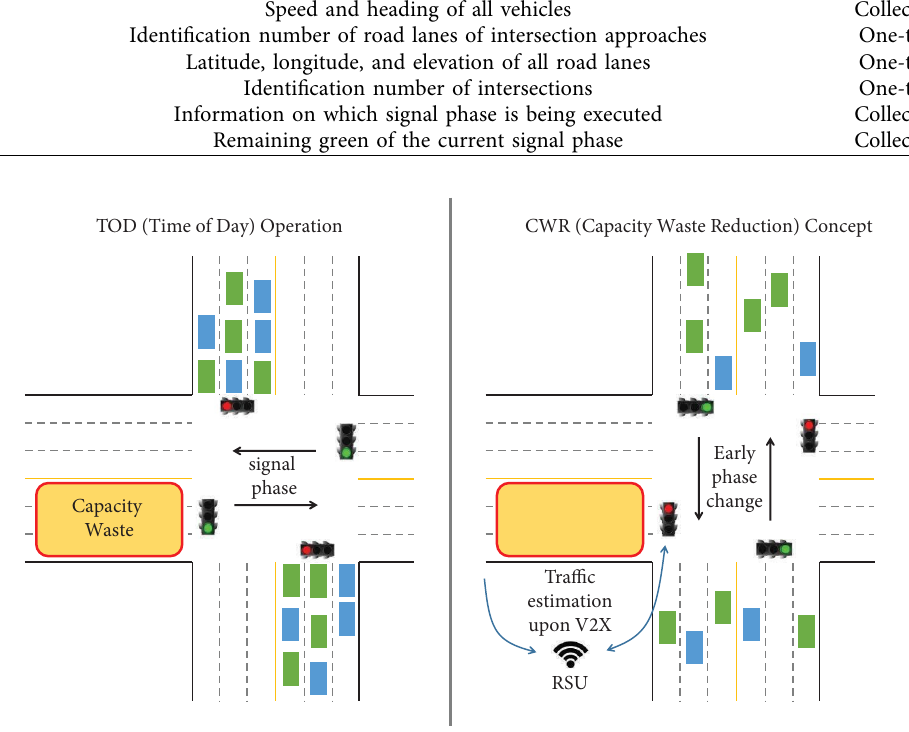
Figure 2: CWR concept: improving trafc fow by reducing unnecessary signal